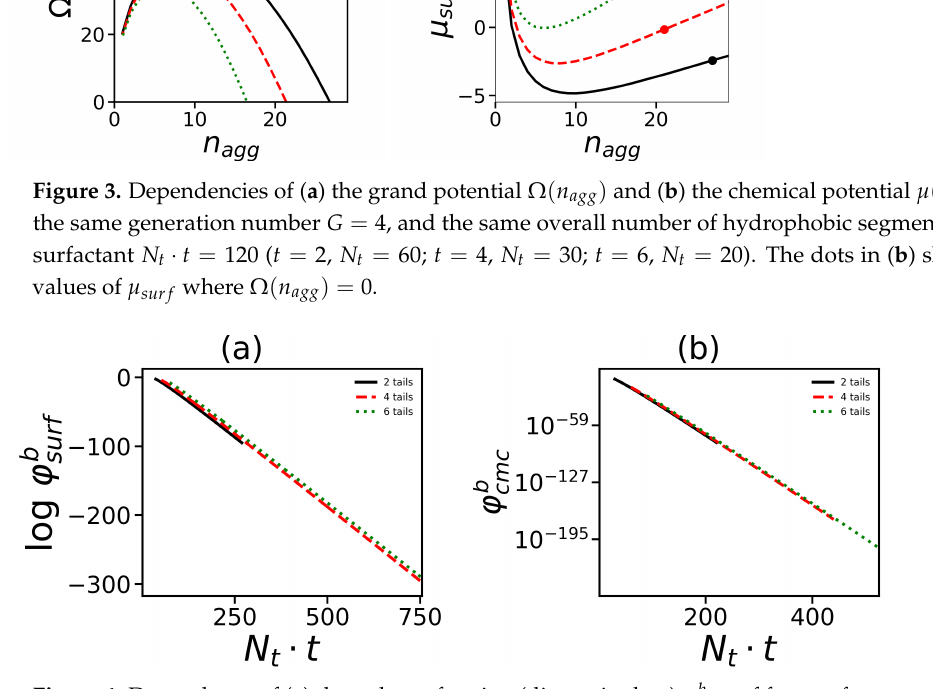
of free surfactant molecules surf